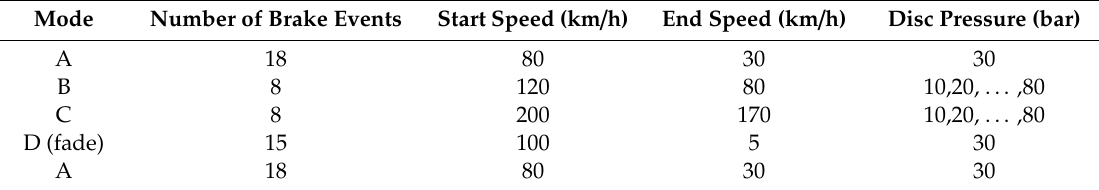
Table 1. Sequence of braking events in the selected AK master